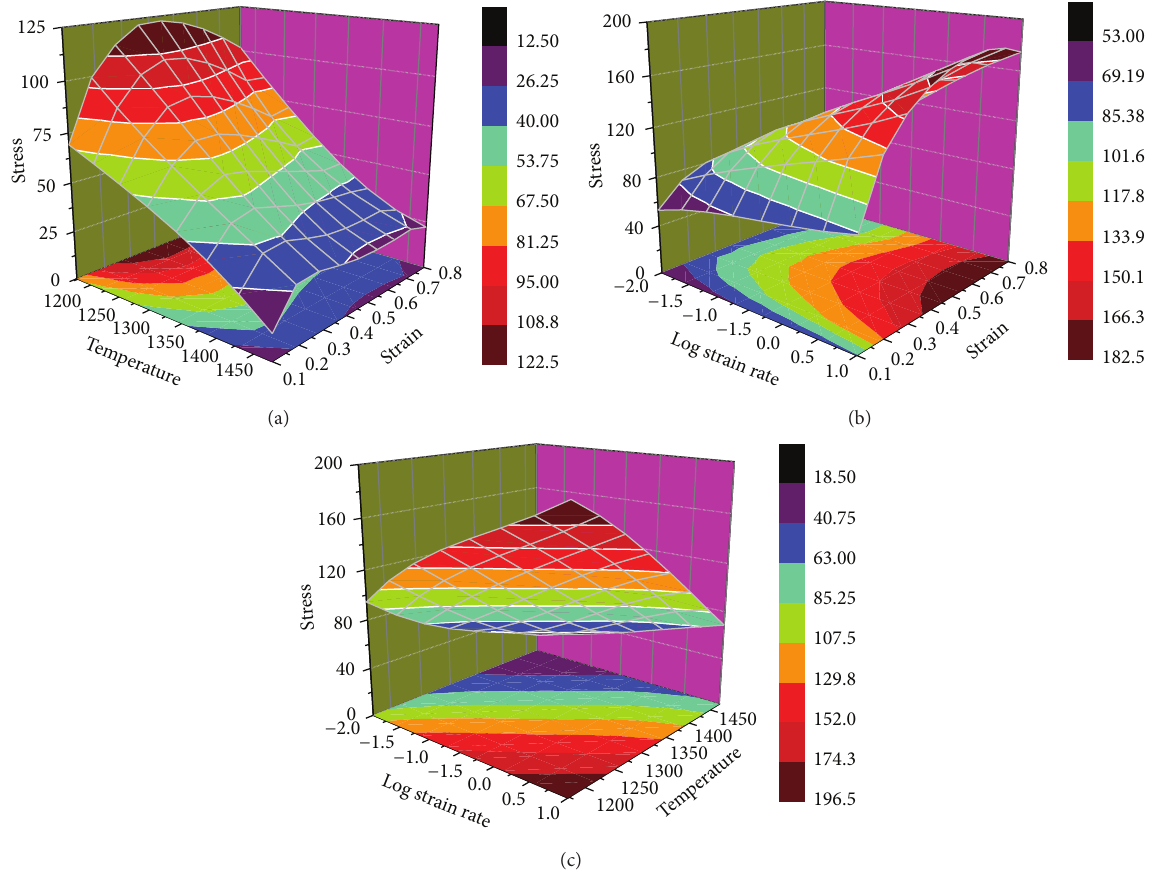
Figure 11: ANN model prediction on the relationship of flow stress versus (a) strain and temperature at strain rate of 0.01 s −1 (b) strain and log strain rate at temperature of 1273 K (c) log strain rate and temperature at strain of